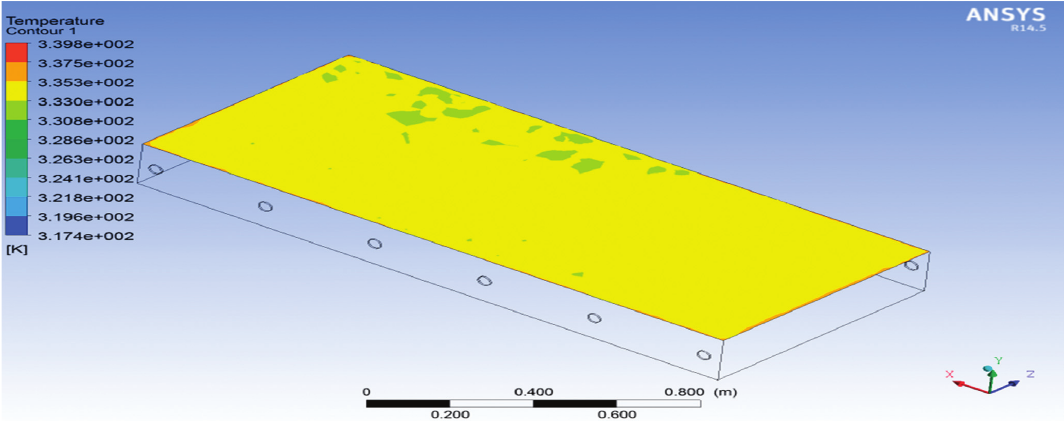
Figure 12: Temperature profile effect on the glass.